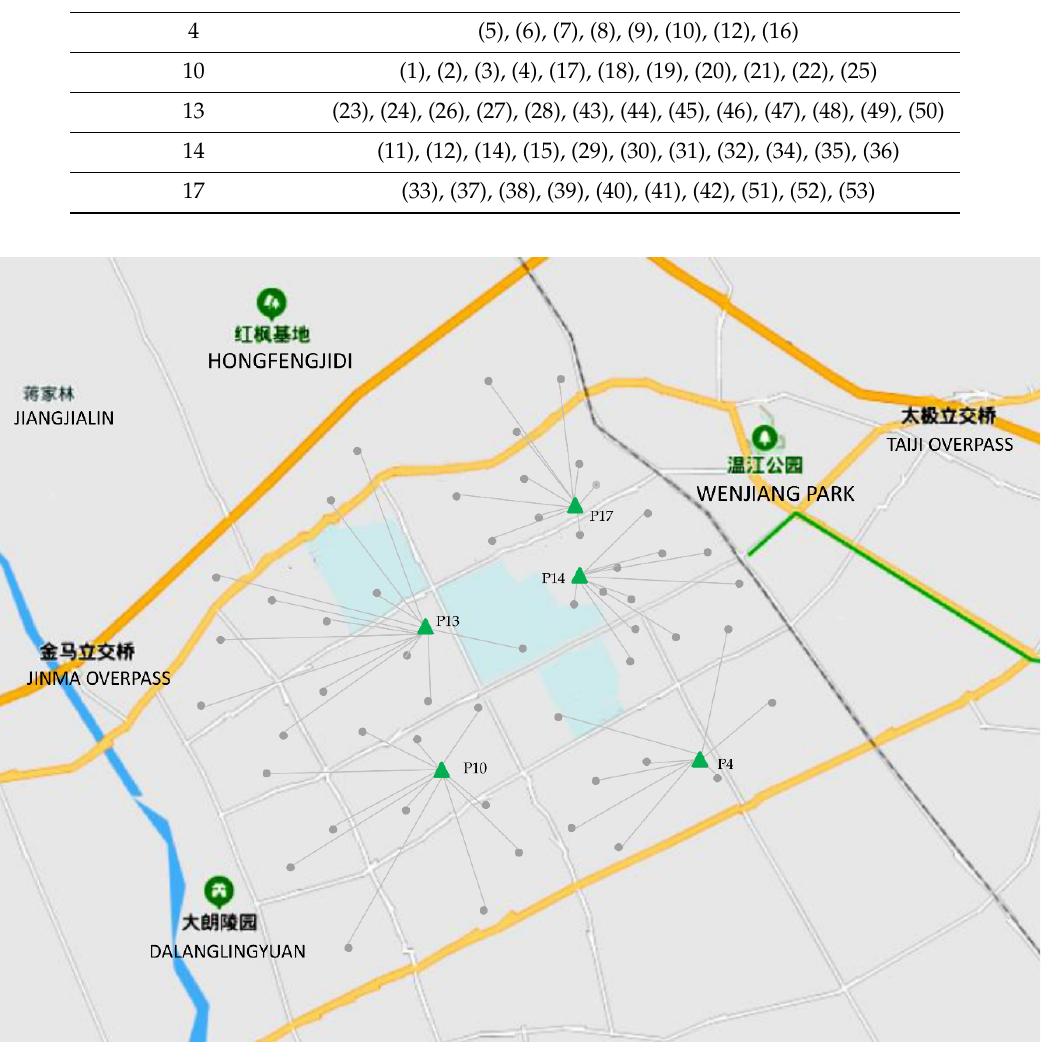
Table 5. The list of selected charging stations and corresponding service areas.